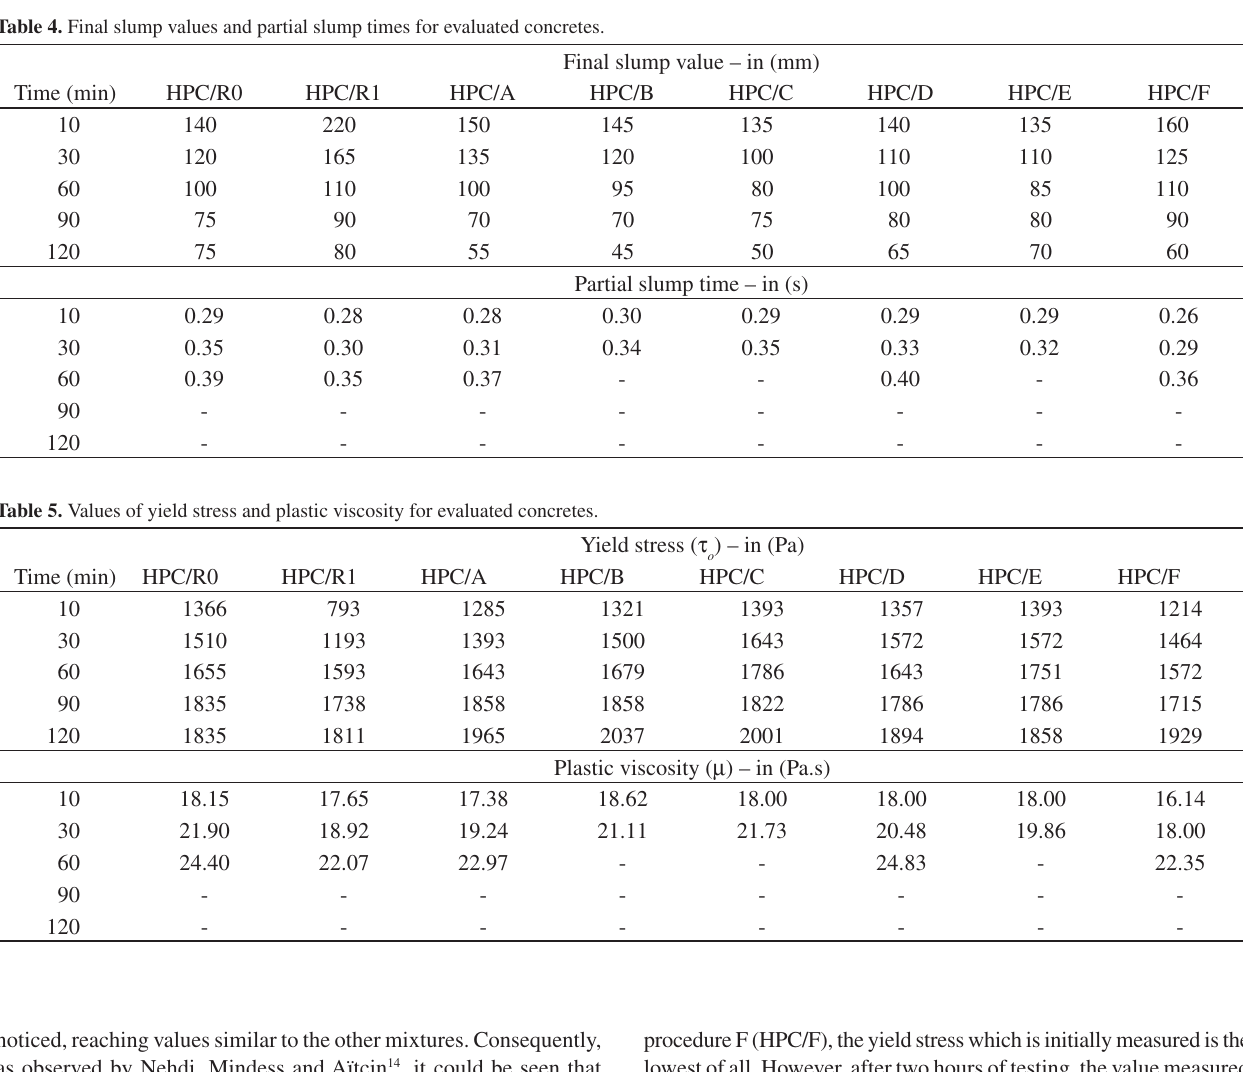
Table 4. Final slump values and partial slump times for evaluated concretes.